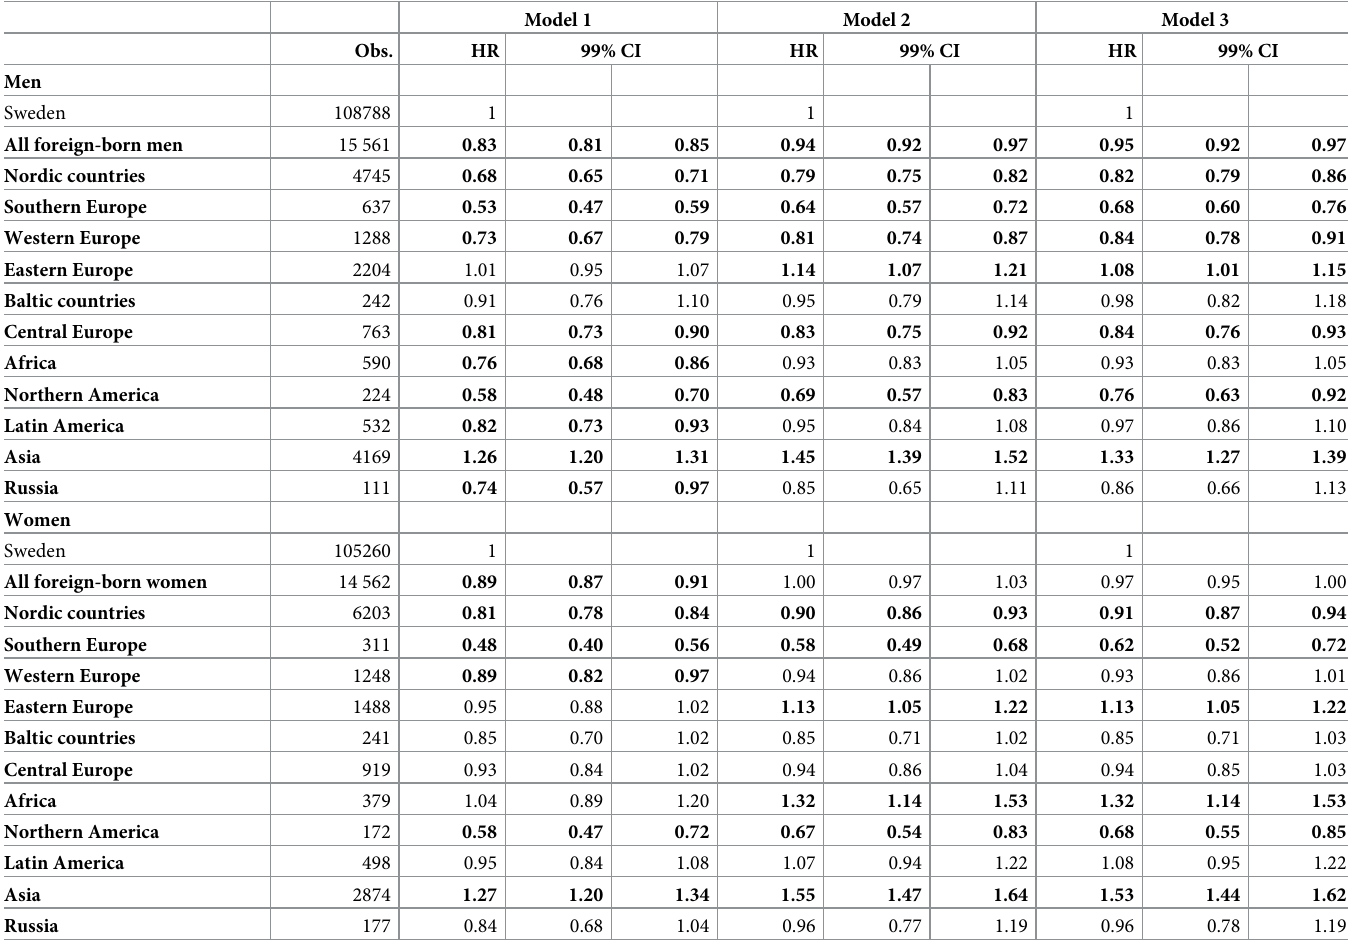
Table 2. Relative risk of hearing impairment in foreign-born men and women with Swedish-born men and women as referents, respectively, expressed as hazard ratios (HR) with 99% confidence intervals (99%